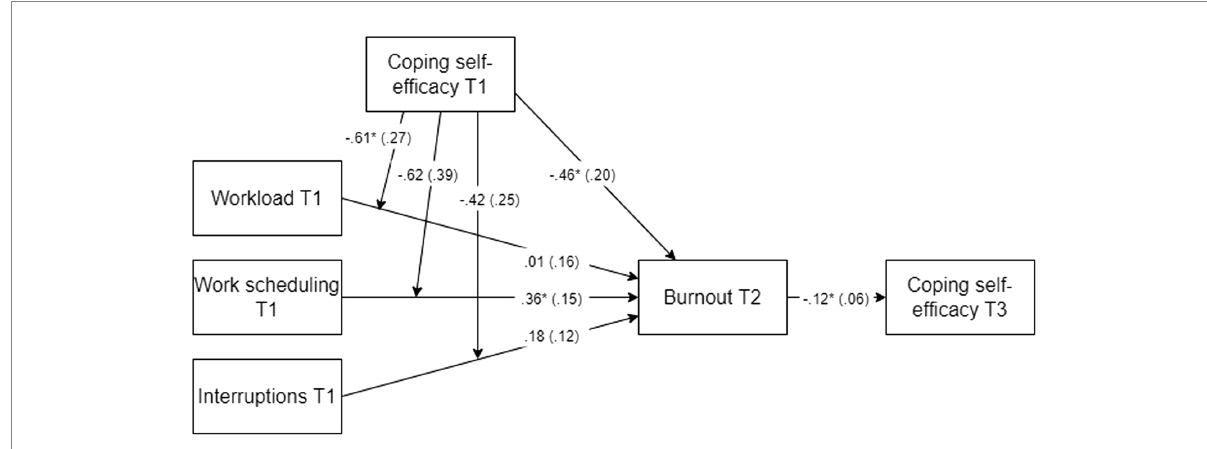
FIGURE 3 Final model. Direct path coefficients (unstandardised b) and moderations are presented with SE in parentheses. N = 95, * p < 0.05, T1 = Time 1, T2 = Time 2, and T3 = Time 3. Results from three separate analyses (per stressor and its interaction with coping self-efficacy) were combined into this